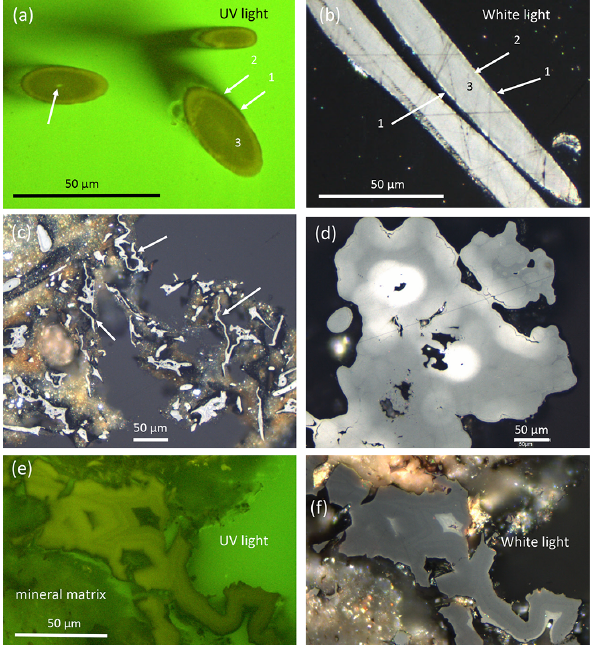
Figure 7. Optical reflected light microscopy of polished grain mounts under UV light for fluorescence and under white light for re- flectance. (a) Cross section of filaments with a central channel (left arrow) and three zones of fluorescence. (b) Longitudinal sections show a symmetrical distribution of the three zones in reflectance, in which the rim with high reflectance corresponds to the rim with low fluorescence shown in (a) . (c) Thin flaky kerite, interpreted as former biofilms (arrows). (d) Botryoidal kerite with zonal distribu- tion of reflectivity. (e, f) Thick masses of flaky kerite with zonal fluorescence and reflectivity.